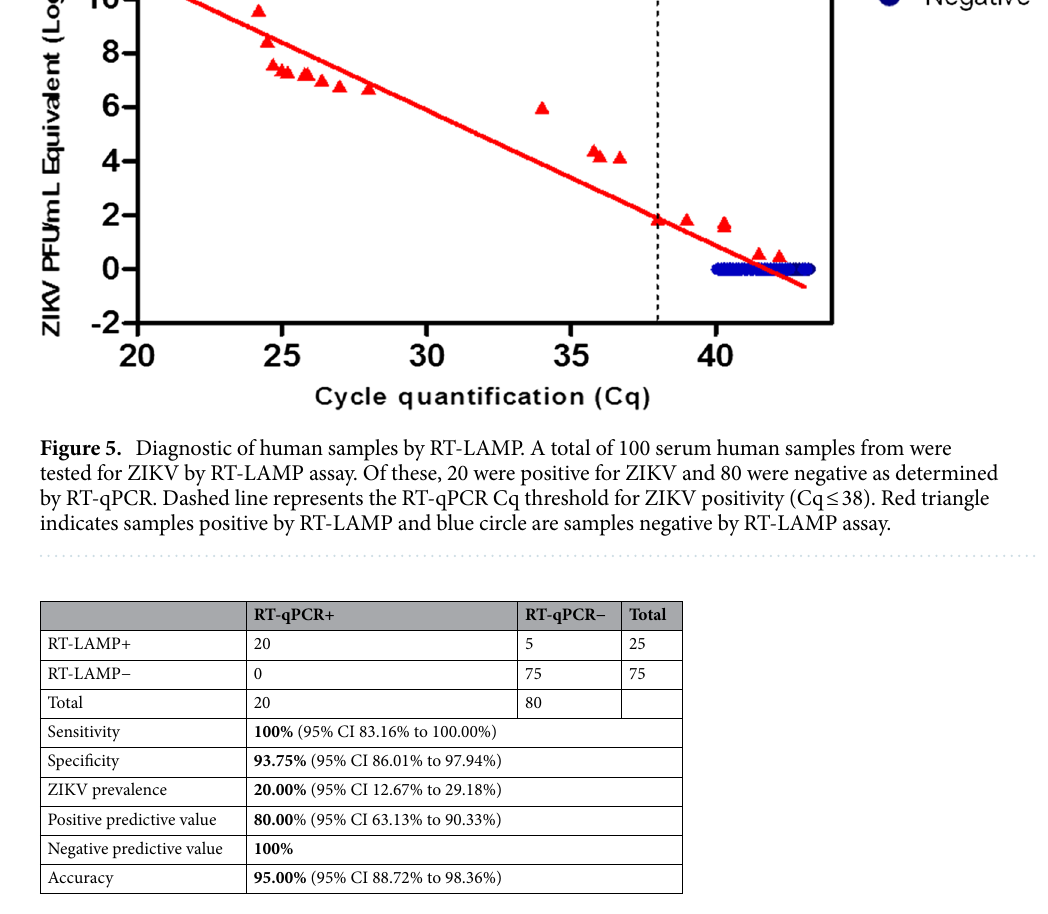
Table 3. Diagnostic performance of RT-LAMP assay for ZIKV detection in patient